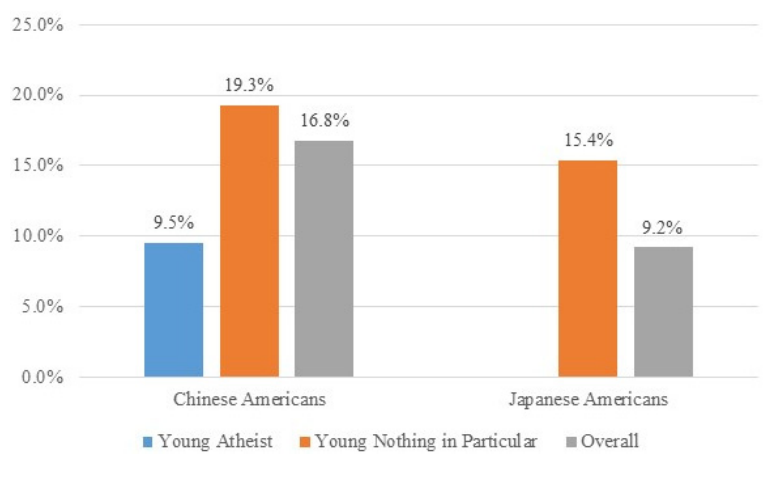
Figure 13. Top goal: having a successful